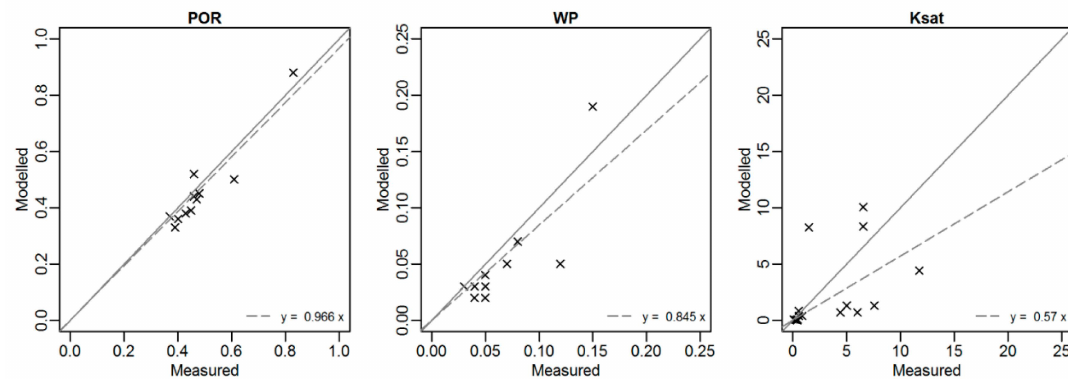
Figure 5. Testing of estimated hydraulic properties against measurements at the sampling points S4, S12, S22 of the S-transect. POR: porosity; WP: permanent wilting point; Ksat: saturated hydraulic conductivity. The dotted lines and their slope are an indication of the discrepancy between estimates and measured data. When the slope is > 1 the measured data are higher than the estimates and when <1 measurements are lower than estimates.